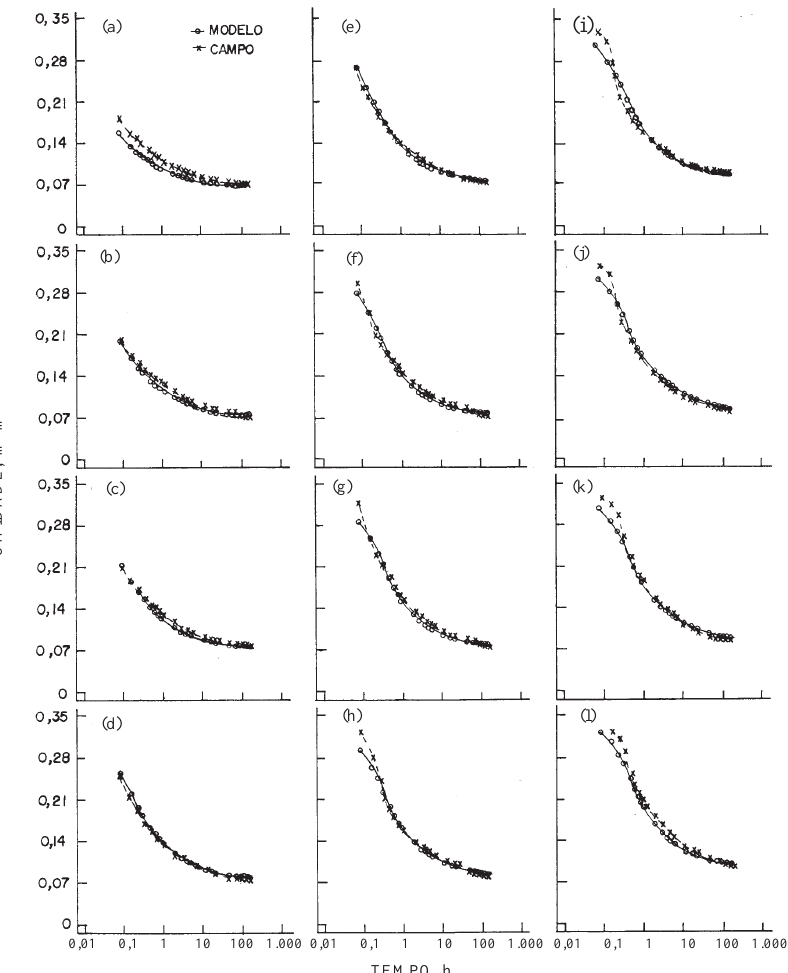
Figura 1. Umidade em função do tempo para o experimento em areia marinha, obtida mediante modelo numérico de Prevedello (1996) e dados de campo de Cho et al. (1977). (As letras a, b, ..., l indicam as profundidades de 0,05; 0,10; 0,15; 0,20; 0,30; 0,40; 0,50; 0,60; 0,70; 0,80; 0,90; e 1,00 m,